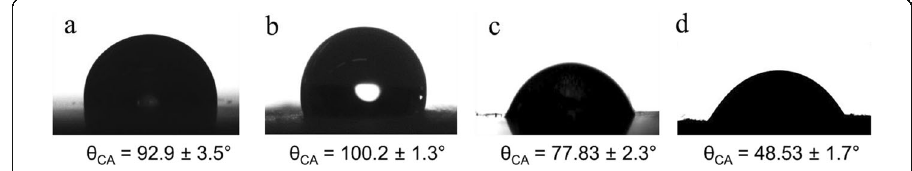
microfiber with